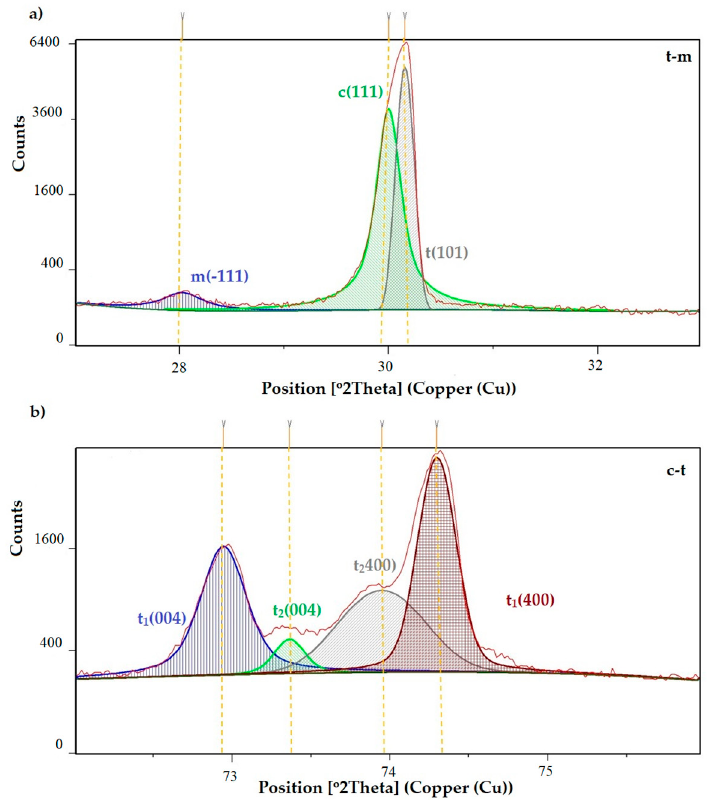
Figure 6. ( a ) t-m, ( b ) c-t transformation of the crown B10_10,000.